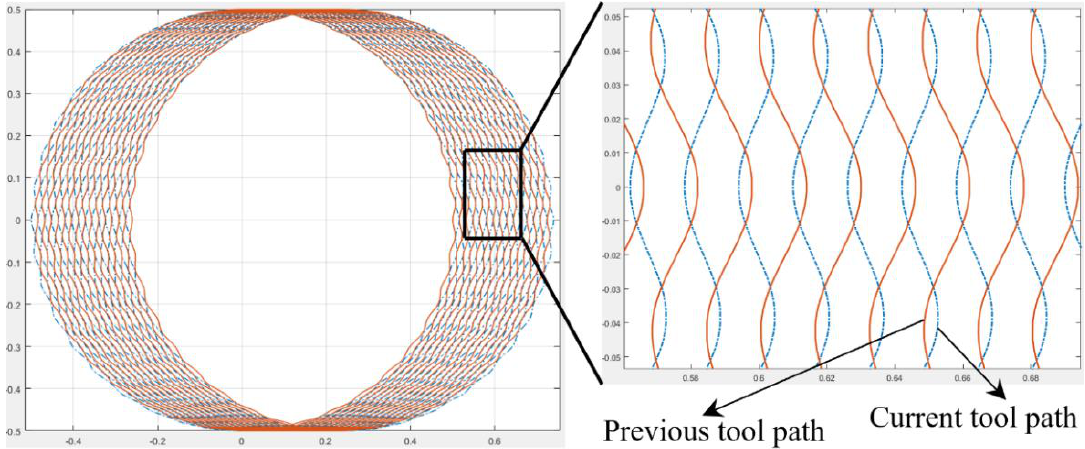
Figure 3. Tool trajectories for the third-type separation condition.